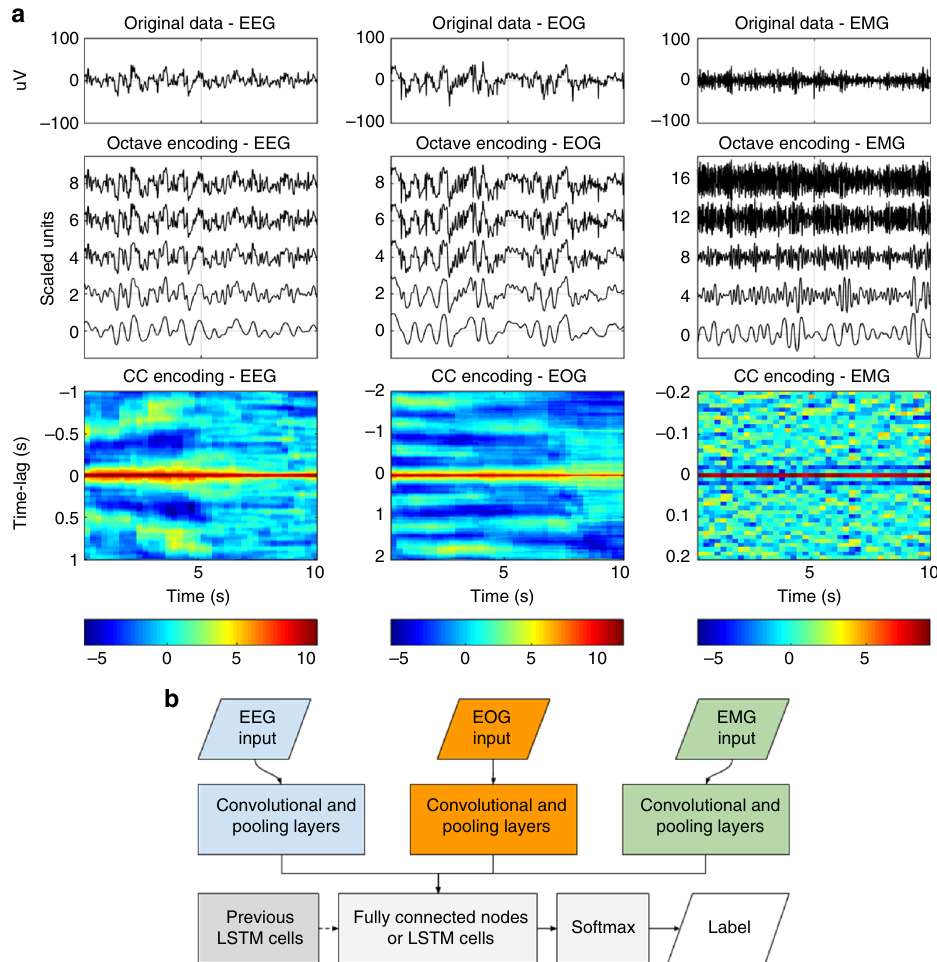
Fig. 6 Neural network strategy. a An example of the octave and the CC encoding on 10 s of EEG, EOG and EMG data. These processed data are fed into the neural networks in one of the two formats. The data in the octave encoding are offset for visualization purposes. Color scale is unitless. b Simpli fi ed network con fi guration, displaying how data are fed and processed through the networks. A more detailed description can be found in